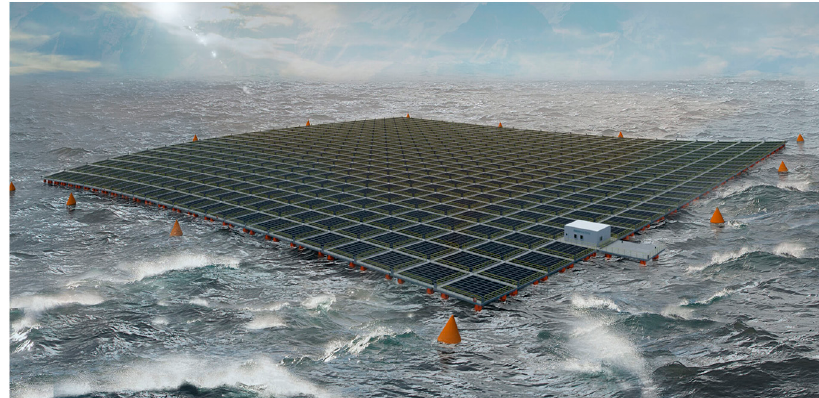
Figure 7. Example of a floating PV (FPV) module.